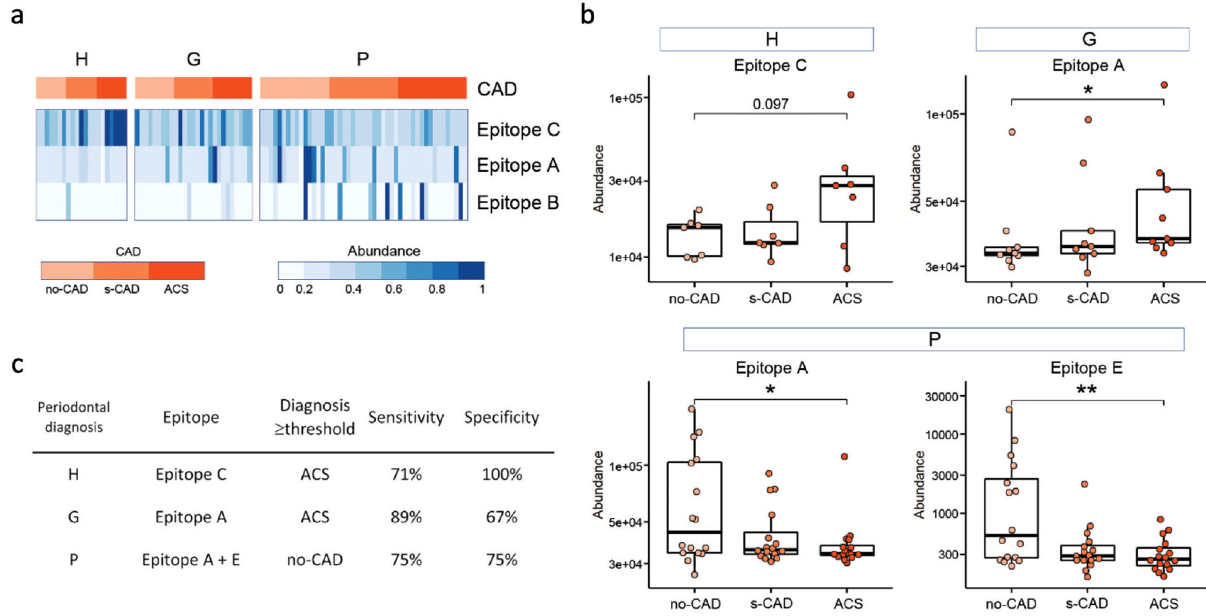
Fig. 5 Immune response to epitope biomarkers to predict the ACS risk in periodontal disease and ascertain the no-CAD phenotype. a Strength of immune response to three epitopes (in rows ) across study subjects ( n = 96, in lanes ), grouped by periodontal (H, G, or P) and CAD diagnosis (no-CAD, s-CAD, or ACS) shown as intensity plots. Relative abundance of immunopro fi le features is shown in blue color-scale. These epitope biomarkers in a 3-biomarker generalized logistic model differentiate P group from H (Supplementary Fig. S11). Vertical lanes – subjects ( n = 96); rows – epitopes; blue color-scale – normalized relative epitope-containing peptide abundance values (using 97.5 th percentile values per feature and capped at value 1). b Different immunopro fi le features ( above boxplots ) strati fi ed ACS with periodontal diagnosis. y-axes : immunoreactivity to epitopes in individual immunopro fi les, shown as abundance of peptides containing the epitope. Mann – Whitney U test, two-sided, p values not corrected for multiple comparisons, ** p <0.01, * p < 0.05. H: n = 21 independent patients; G: n = 27 independent patients; P: n = 48 independent patients. c Sensitivity and speci fi city measures of using biomarkers from B in separate periodontal groups ( sub-group ) to predict CAD diagnoses (either no-CAD or ACS). Diagnosis ≥ threshold – diagnosis group into which patient was classi fi ed if immune response was over threshold. a – c Abbreviations and group sizes: H -periodontally healthy ( n = 21), G -gingivitis ( n = 27), P -periodontitis ( n = 48), no-CAD -no CAD diagnosis ( n = 32), s-CAD - stable CAD ( n = 32), ACS - acute coronary syndrome ( n = 32). Data in File